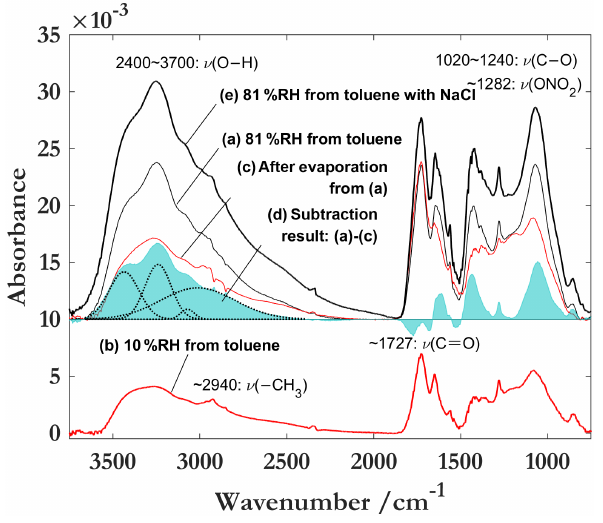
Figure 5. Infrared spectra of SOA from toluene irradiations under humid (a) and dry (b) conditions. The infrared spectrum of (c) was obtained after evaporation of SOA from (a) for 15min at 110 ◦ C; the difference spectrum between (a) and (c) is in the blue area (d) ; the infrared spectrum of (e) is with extra LWC by NaCl seeds. The main bands are the hydrogen bonded O–H stretch in alcohols or acids (2400–3700cm − 1 ), the carbonyl (C = O) band at 1727cm − 1 , the organonitrate (ONO 2 ) bands at 1636, 1278, and 855cm − 1 , the C–OH band at 1423cm − 1 , and the C–OH stretch at 1080cm − 1